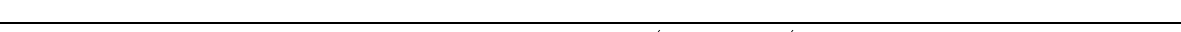
Fig. 5 Plekhg5 regulates biogenesis of autophagosomes. a Motoneurons of Plekhg5 + / + and Plekhg5 − / − mice were transduced with mRFP-GFP-LC3- expressing lentiviruses and cultured for seven days. At day seven cells were treated with Ba fi lomycin A1 for four hours or left untreated and the number of autophagosomes (mRFP + -GFP + -LC3) and autolysosomes (mRFP + -GFP − -LC3) was determined in the soma b and axon c (three independent experiments with 15 cells analyzed in each experiment; mean ± SEM; two-way ANOVA; Bonferroni post-test). Soma, scale bar : 5 µ m. Axon, scale bar : 20 µ m. Axon ( blow up ), scale bar : 5 µ m. d Representative kymographs of autophagosome motility. Cultured motoneurons were transduced with mRFP-GFP-LC3 and the movement of GFP positive punctae in axons was monitored for 20 min. e Proportion of retrogradely, anterogradely or stationary/bidirectionally moving autophagosomes (mean ± SEM; n = 10 cells; two-way ANOVA; Bonferroni post-test). f Number of retrogradely moving autophagosomes per minute (mean ± SEM; n = 10 cells; Student ʼ s t -test; one-tailed). g Western blot analysis of LC3 expression in neurosphere-derived cortical neurons from control and Plekhg5-de fi cient mice. Cells were treated with 400nM Ba fi lomycin A1 for 4 h or left untreated. LE low exposure, HE high exposure. h Quanti fi cation of LC3 western blots. (Mean ± SEM; n = 3; mean ± SEM; one-way ANOVA). i Expression of LC3 in spinal cord lysates of three mice per genotype. j Quanti fi cation of LC3 Western blots from spinal cord extracts. (mean ± SEM; n = 4; mean ± SEM; Student ʼ s t -test; two-tailed). k NSC34 cells were transfected with Plekhg5-YFP. Seventy-two hours after transfection, cells were starved for 4 h in HBSS or left untreated. The expression of Plekhg5-YFP was analyzed by western blot. l Motoneurons were cultured for seven days in motoneuron-media. At day seven cells were cultured for 4 h with different media each deprived of speci fi c components. Subsequently, motoneurons were lysed and the expression of endogenous Plekhg5 was analyzed by western blot. Asterisks label bands that do not change upon nutrient deprivation. Arrowheads point to bands that change upon nutrient deprivation. m NSC34 cells were transfected with Flag-Plekhg5. Seventy-two hours after transfection, cells were lysed and Flag-Plekhg5 was pulled-down with PI(3)P-coated beads. Western blot images have been cropped for presentation. Full size images are presented in Supplementary Fig.